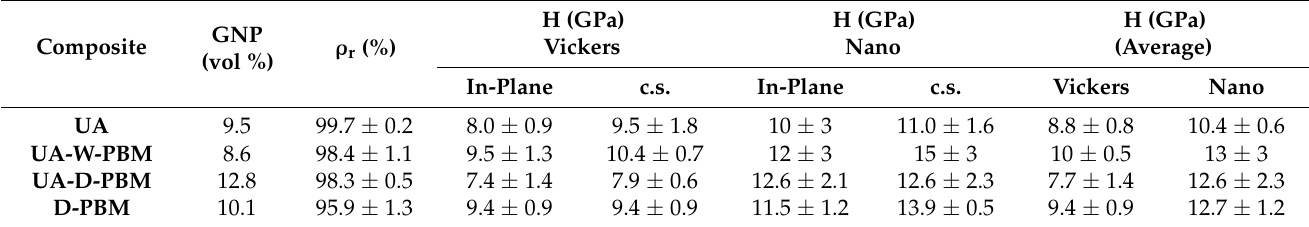
Table 2. Vickers hardness and instrumented hardness on each orientation of the composite (in-plane and cross section) and average values. The real GNP content and the relative density of the composites are also